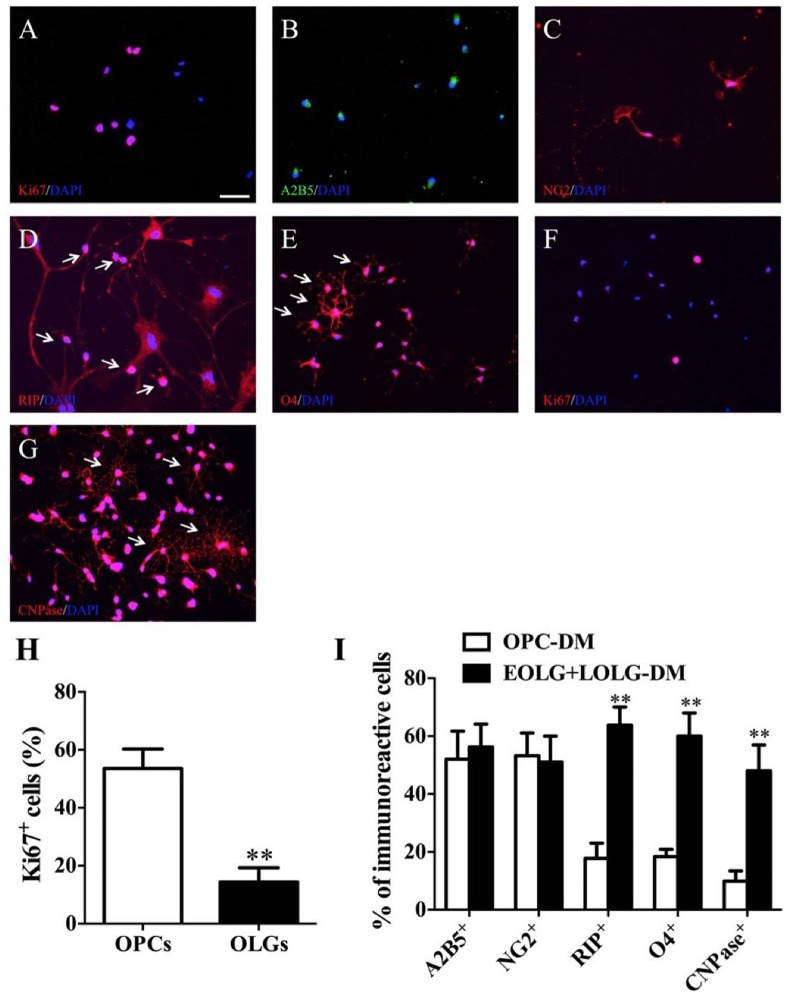
Fundamental steps of BM-NSCs OLGs differentiation. (A) Expression of Ki-67 at day 38, as shown by immunofluorescence analysis. (B,C) Immunofluorescence staining of progenitor cells at day 38, expressing A2B5, and NG2. (D,E) RIP and O4 staining show cells ramified morphology. (F) Expression of Ki-67 which in late stage of OLGs differentiation (day 52). (G) At the end of differentiation stage, CNPase+ OLGs show typical ramified morphology. (H) OPCs and OLGs proliferation (A,F) was quantified as percentage of Ki67-positive cells. Scale bar = 50 μm. (I) The percentages of A2B5+, NG2+, RIP+, O4+, and CNPase+ cells are present in EOLG+LOLG-DM cultures as compared to OPC-PM cultures. Data are expressed as the mean ± SD, three independent experiments, ∗∗p < 0.01, Student’s t-test.